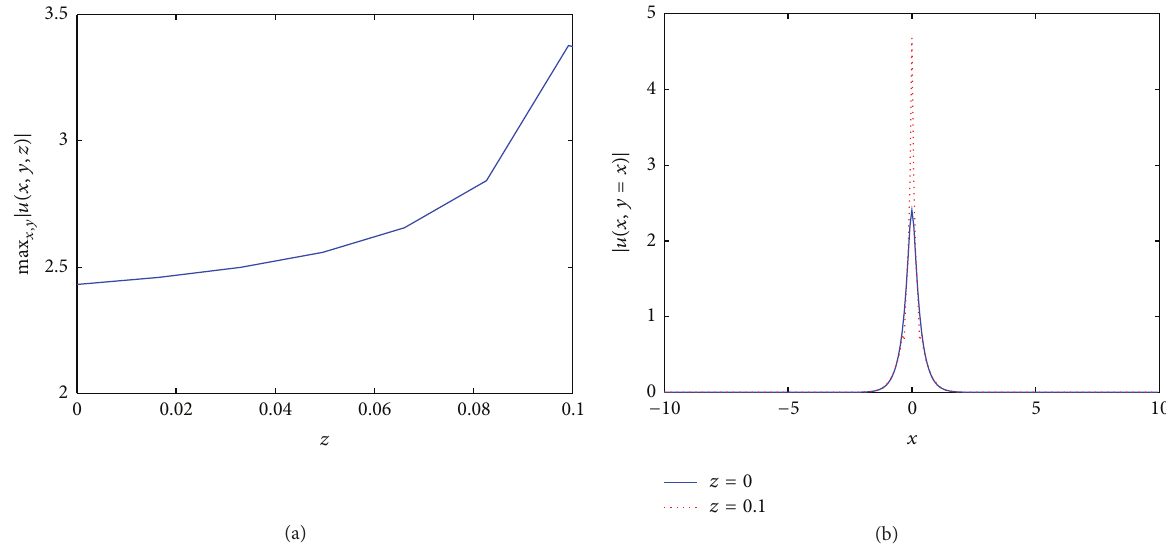
Figure 23: Nonlinear evolution of the lattice soliton situated at the Penrose potential with 𝜇 = 5 for the self-focusing quintic model. (a) Peak amplitude of the lattice soliton as a function of the propagation distance. The initial condition is taken as the lattice soliton with a 0.01 noise in the amplitude and phase; (b) cross section along the diagonal axis of the lattice soliton before and after evolutions ( 𝑧 = 0 and 𝑧 = 0.1